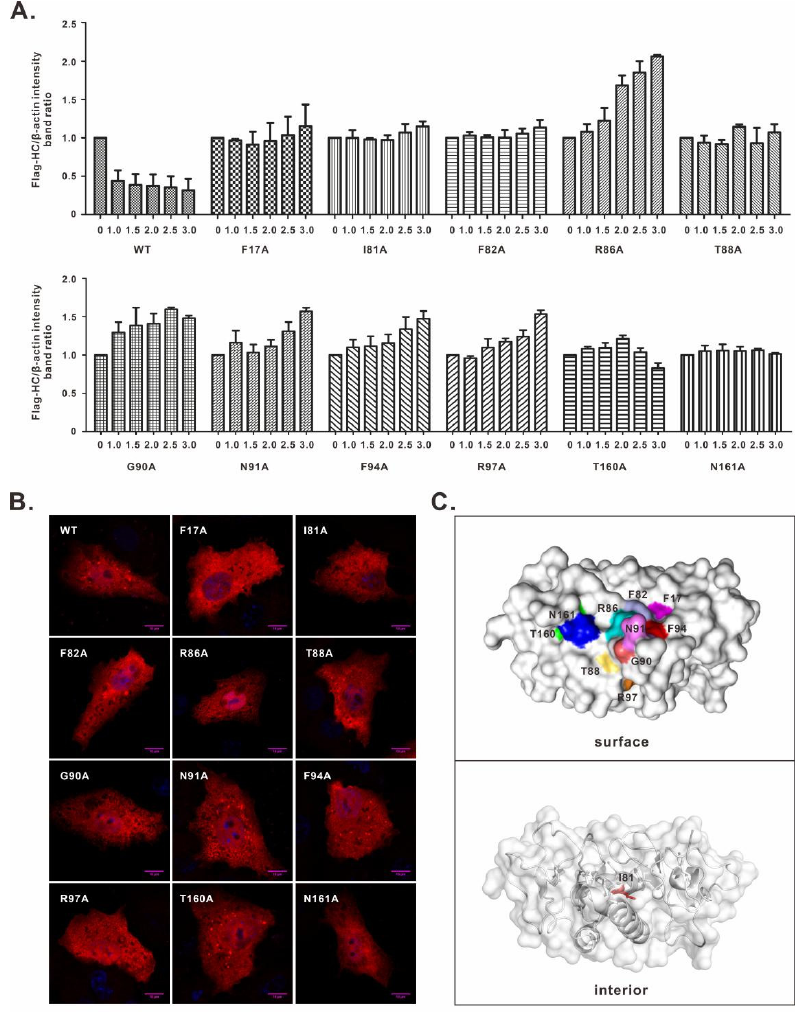
Figure 2. Characterization of the key residues involved in nsp1 α -induced SLA-I degradation. ( A ) Dose-dependent effect of nsp1 α or its derivatives on inducing degradation of FLAG-SLA-I-HC. HEK 293T cells were transfected to co-express FLAG-SLA-I-HC in combination with an increasing amount (i.e., 0, 1.0, 1.5, 2.0, 2.5, and 3.0 μ g) of HA-nsp1 α or its derivatives. At 36 h post-transfection, the cells were subject to Western blot analysis. The result showed the band intensity ratio between FLAG-SLA-I-HC and β -actin. ( B ) Vero cells were transfected to express WT HA-nsp1 α or its mutants. At 24 h post-transfection, the cells were fixed, permeabilized, and stained with anti-HA antibody. DAPI was used to stain cell nuclei. The images were acquired by a Nikon A1 confocal micro- scope and are representative of three independent experiments. ( C ) Structural distribution of the nsp1 α critical residues. The 3D structure of nsp1 α is shown in surface and cartoon modes, and the residues are highlighted in different colors.